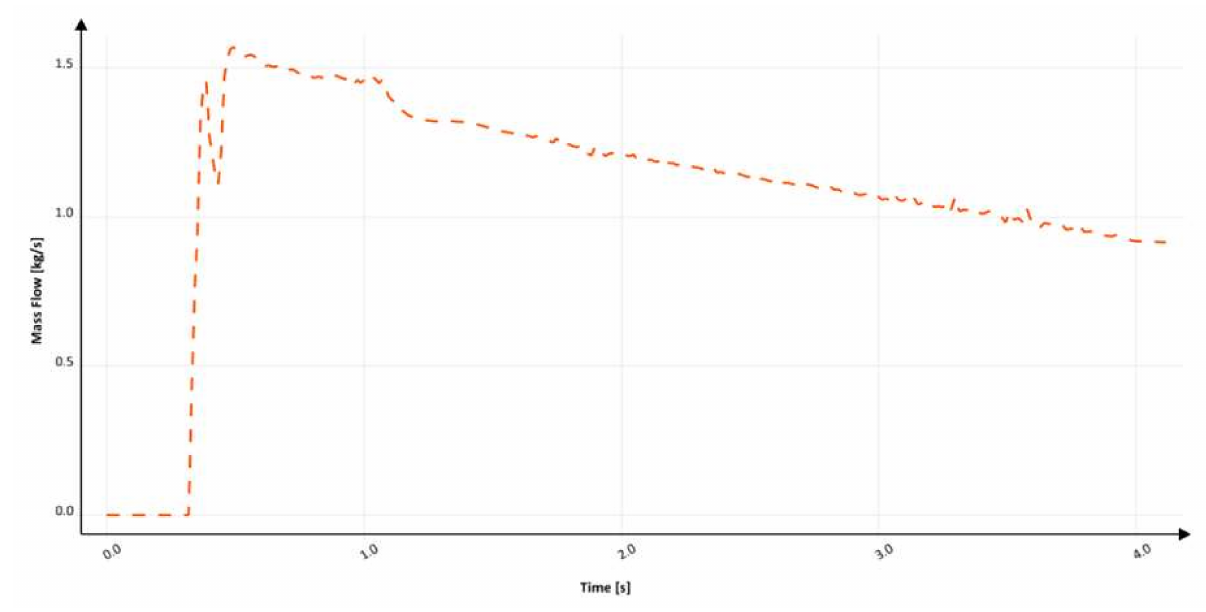
Figure 22. Mass flow through ingate with round, reverse tapered sprue (S s 3),